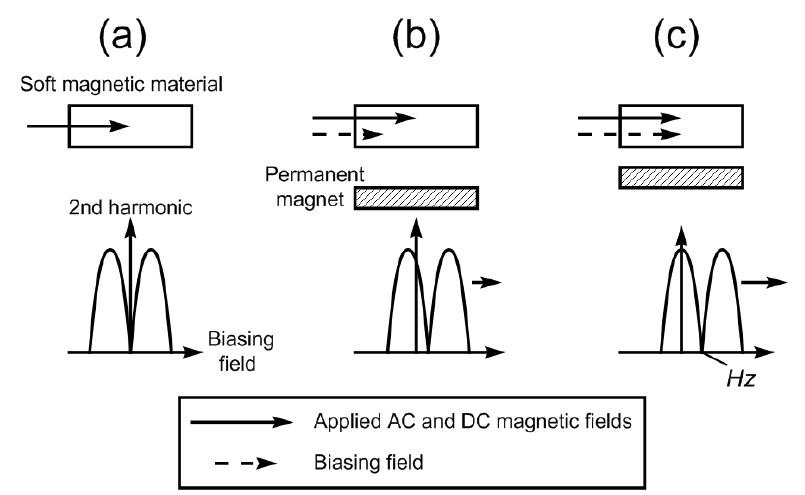
Figure 1. The operational principle of the described implantable sensor. (a) In the absence of the permanent magnet, the soft magnetic material generated a symmetrical 2 nd order harmonic field as a function of the applied DC field. (b) The placement of a permanent magnet, which created a secondary DC field (biasing field), shifted the harmonic field pattern. (c) As the separation distance between the two magnetic elements decreased, the secondary biasing field experienced by the soft magnetic material increased. This further increased the shift of the harmonic field